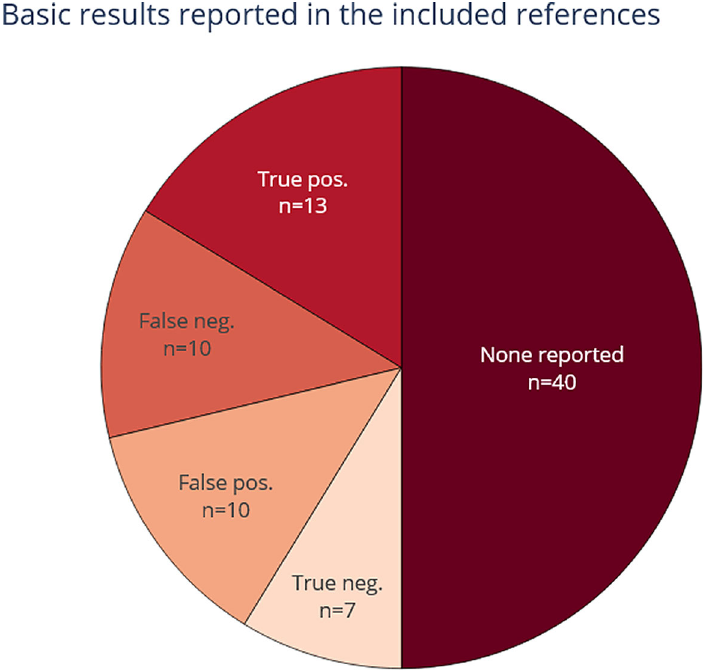
Figure 10. Reporting of basic metrics (true positive, false positive, true negative, and false negative). For each included paper. More than one selection is possible, which means that the total number of included publications (n=53) is lower than the sum of counts within this